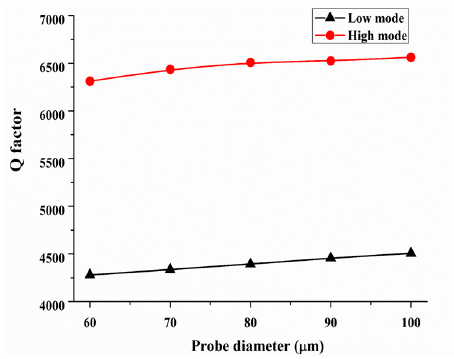
Figure 15. Q -factor of the QTF-p with changes of the tungsten probe diameter at the high and low modes.